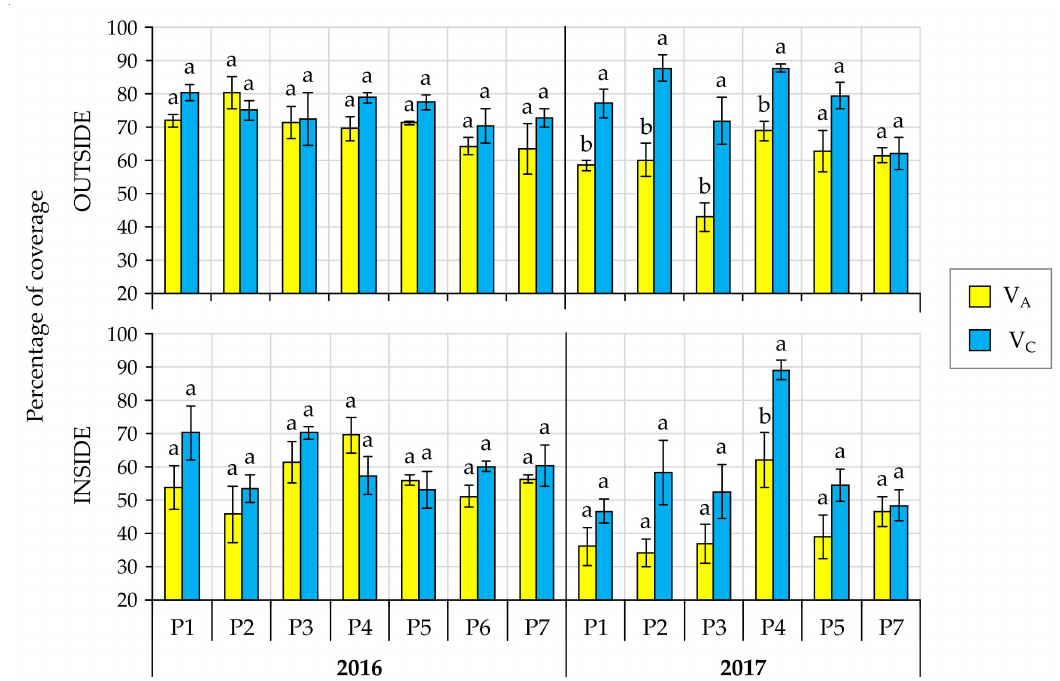
Figure 4. Spray coverage (%) (mean value with standard error bar) obtained on the outside and inside parts of clementine tree canopies after application of conventional (V C ) and adjusted (V A ) volume rates in each orchard on different locations (P1–P7) over the years 2016 and 2017. Different letters above the bars for each coverage evaluation indicate significant differences (LSD test, p <